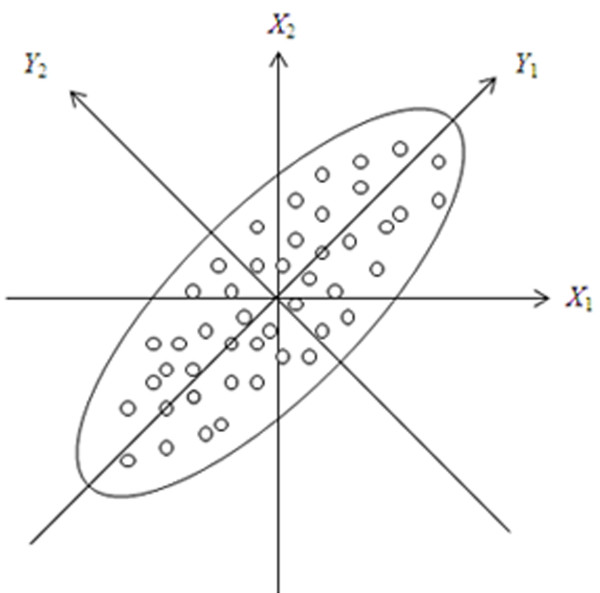
Geometric meaning of PCA explained by using bivariate normally distributed variables. Scatters of sample are distributed in the shape of ellipse roughly, then orthogonally rotate the original plane rectangular coordinates composed of X1 and X2with an angle θ. By now, two original correlated variables(X1, X2)were transformed into two integrated and uncorrelated variables (Y1,Y2). Because the variance of the original variables is greater in Y1 axis than in Y2 axis, so the minimum of information will be lost if integrated variable Y1 is used for replacing all original variables. Hence,Y1 is defined as the first principal component; in contrast, variance of variables is smaller in Y2 axis, and it can explain minor information relative to Y1, soY2 is called the second principal component.